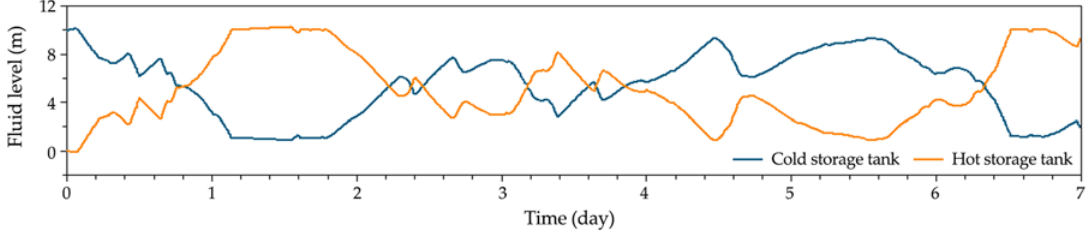
Figure 12. Simulated results of the fluid levels in cold and hot molten salt storage tanks.